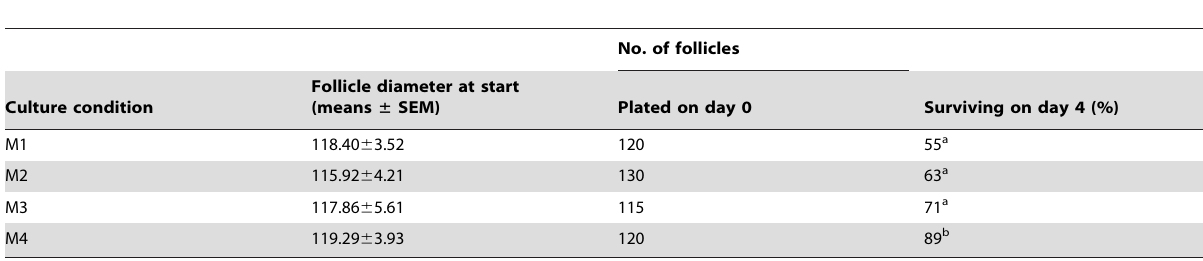
Table 1. Effect of different culture system on the oocyte growth of preantral follicles at day 4.